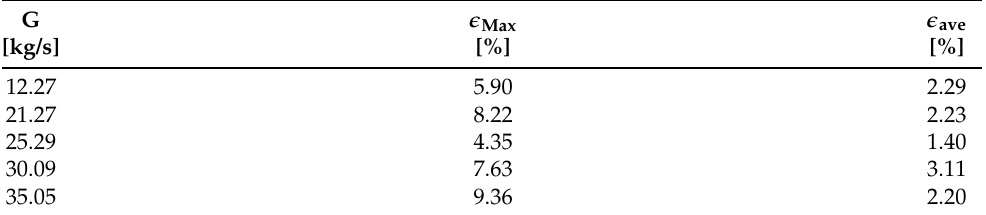
Table 10. Maximum and average relative errors on mass flow rate distributions among OVT mock-up PFU